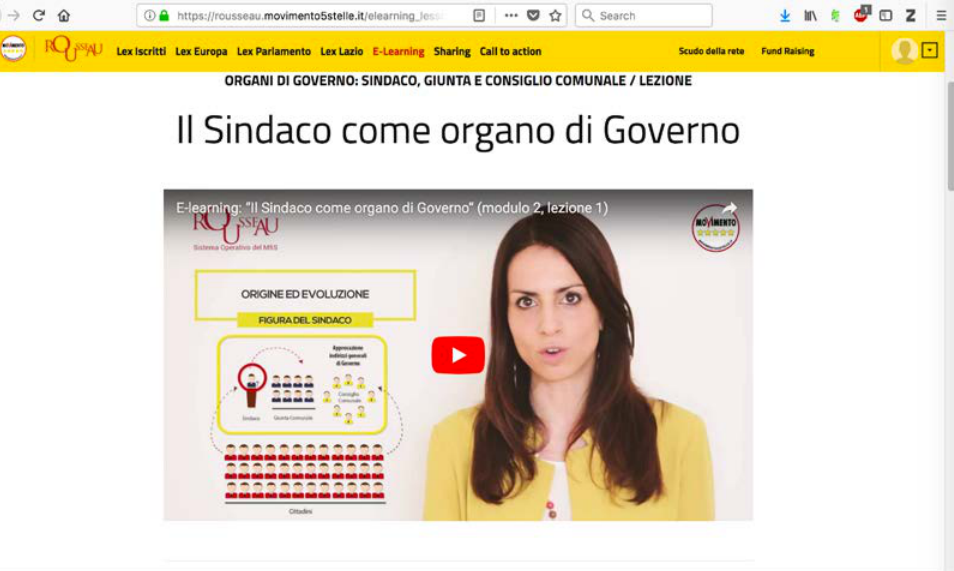
Figure 5: A tutorial in the E-learning area of Rousseau (source: